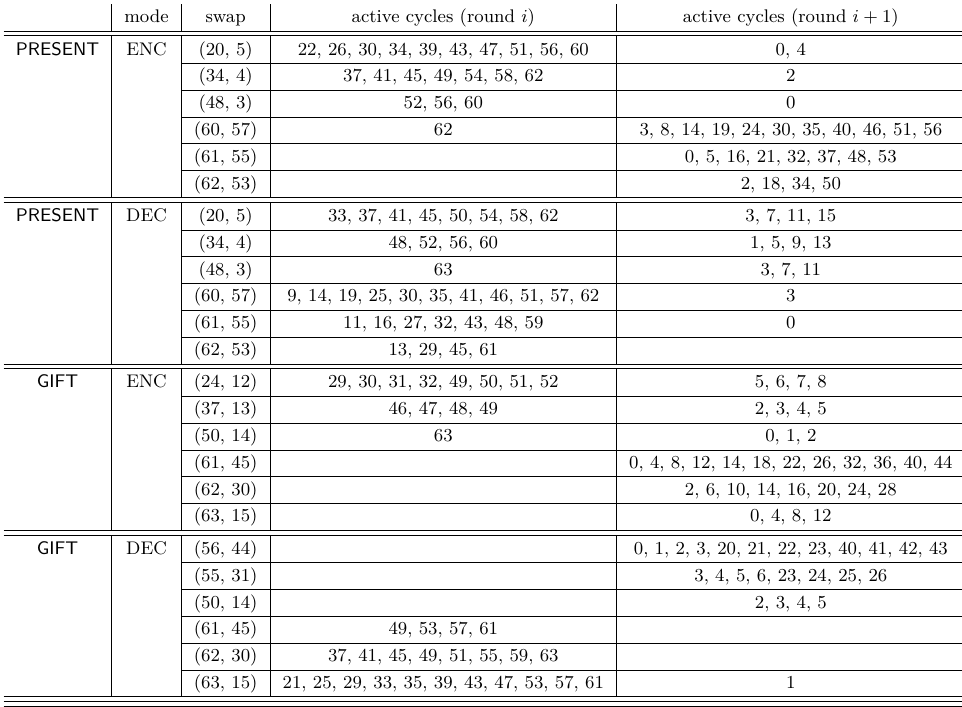
Table 11: Realization of GIFT and PRESENT permutations in 64